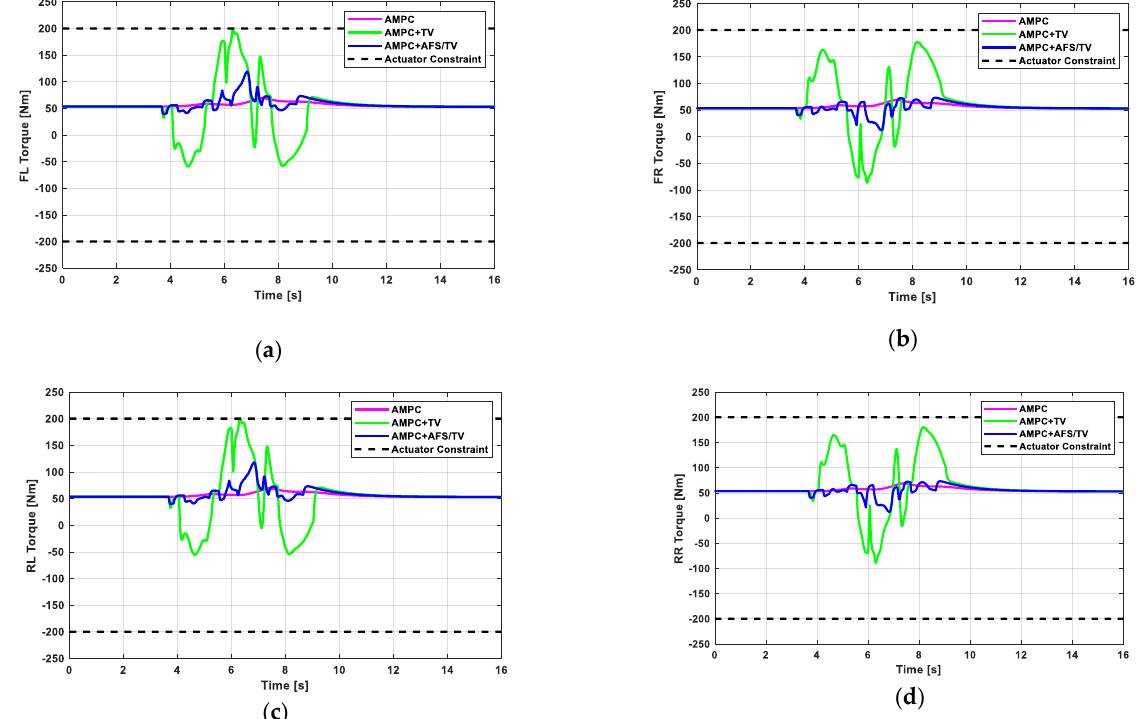
Figure 9. Independent in-wheel motors (IWM) torque: ( a ) front-left, ( b ) front-right, ( c ) rear-left, and ( d )